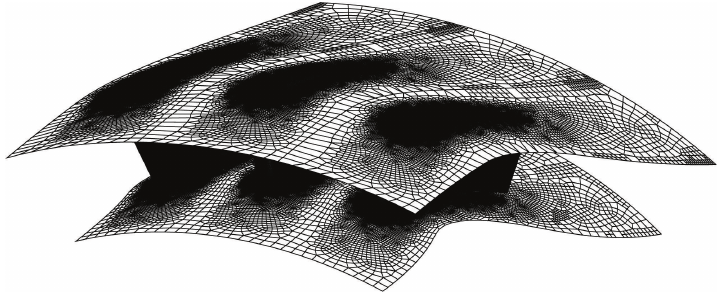
Figure 5: Computational grid.